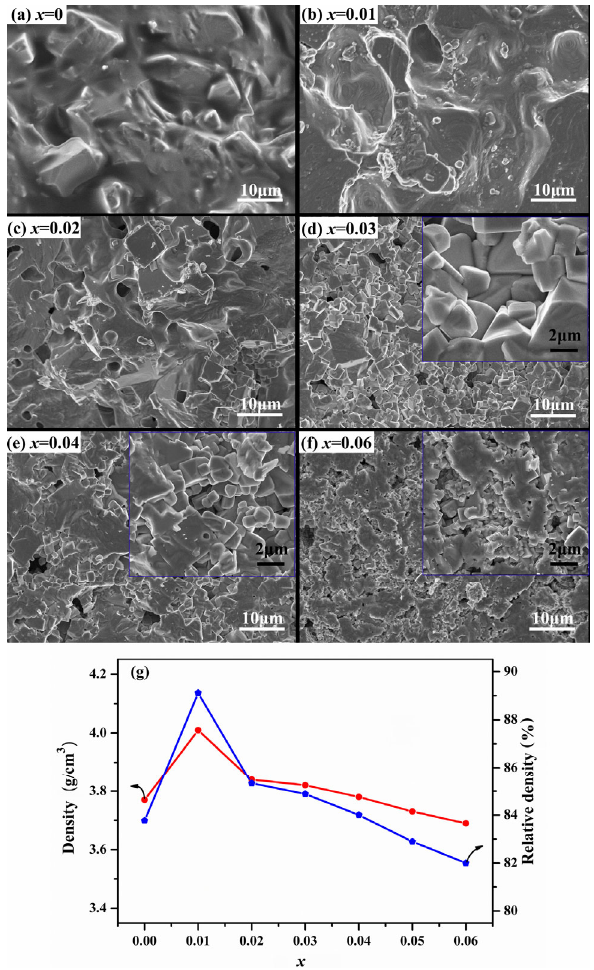
Fig. 1 Microstructure of KNN– x BLZ ceramics: (a) x = 0, (b) x = 0.01, (c) x = 0.02, (d) x = 0.03, (e) x = 0.04, (f) x = 0.06; and (g) density and relative density.